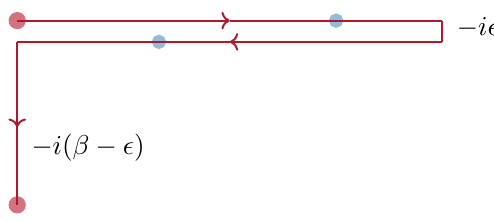
Figure 1 . Schwinger-Keldysh imaginary time contour with an initial thermal